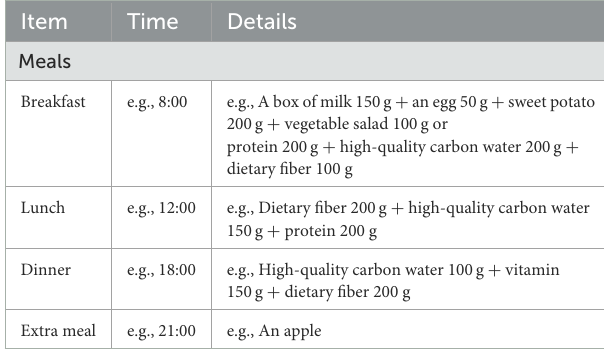
TABLE 1 Health dietary behavior